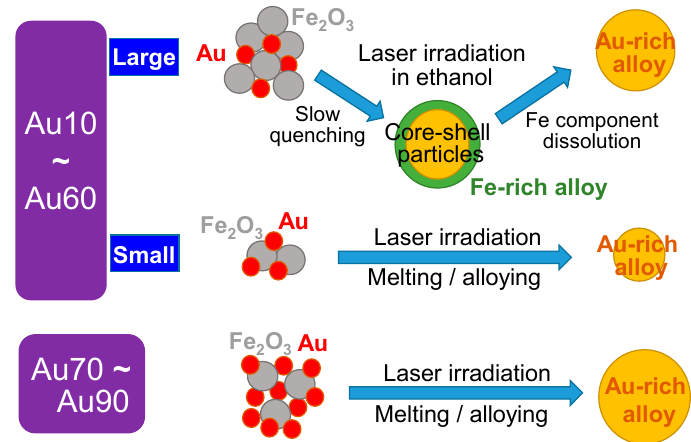
Figure 10. Schematic illustration of the Au-Fe submicrometre spherical particle formation process by PLML in ethanol.